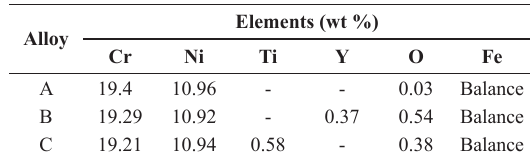
Table 2: Summary of EDS analysis of bright phase and dark phase in alloy A.